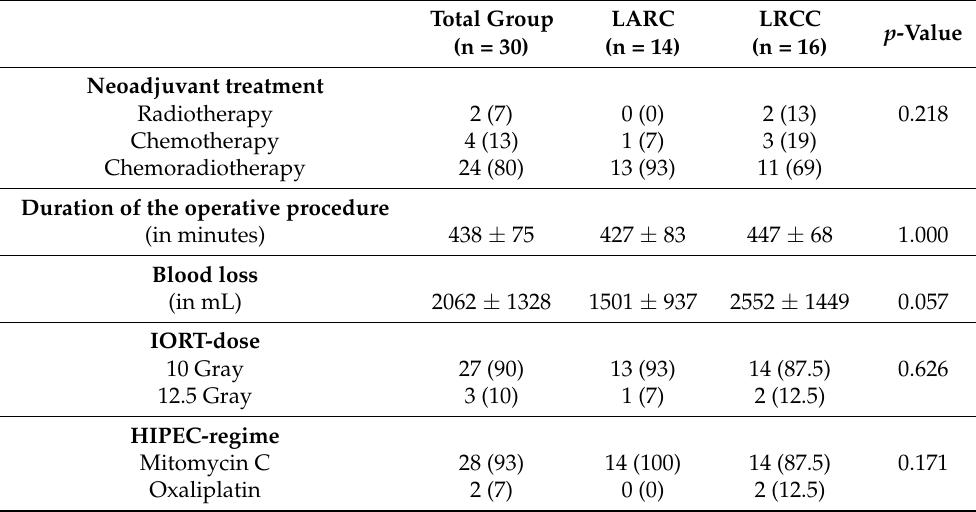
Table 2. Treatment